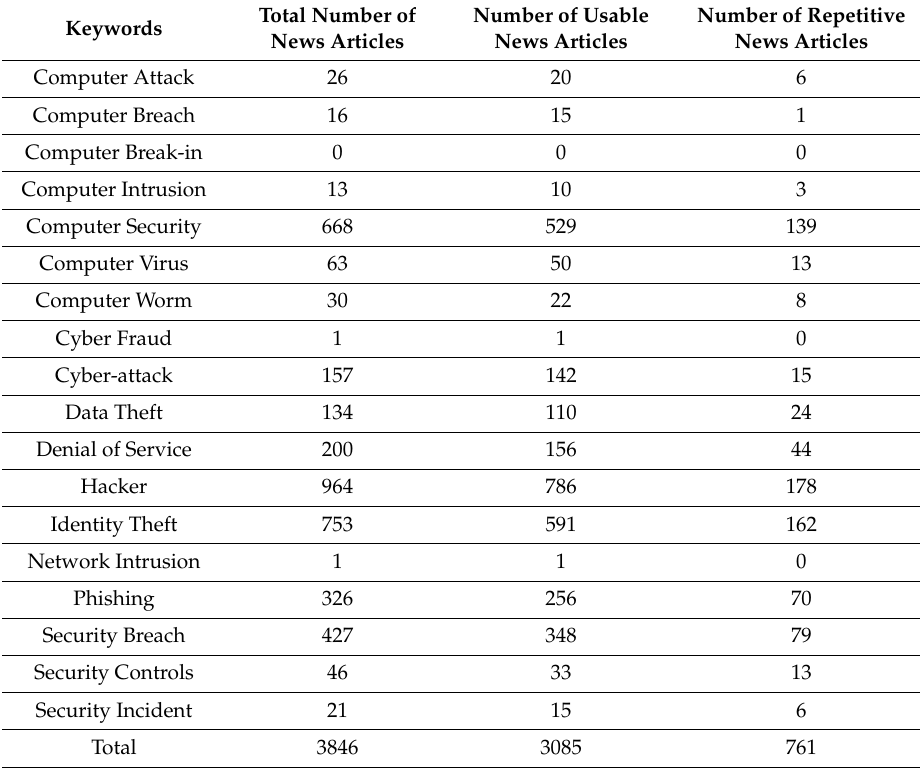
Table 6. The number of news articles after preliminary